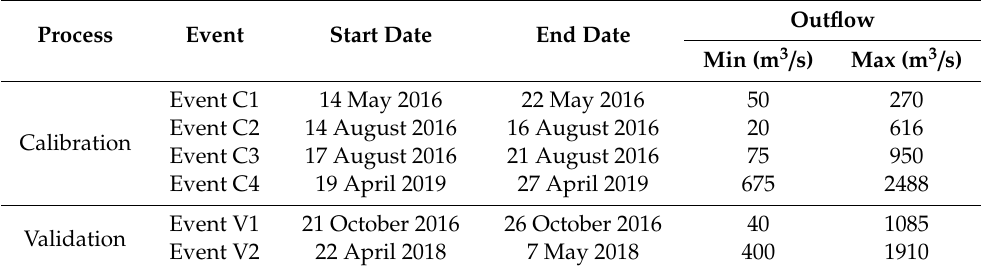
Table 1. Events considered in the calibration and validation